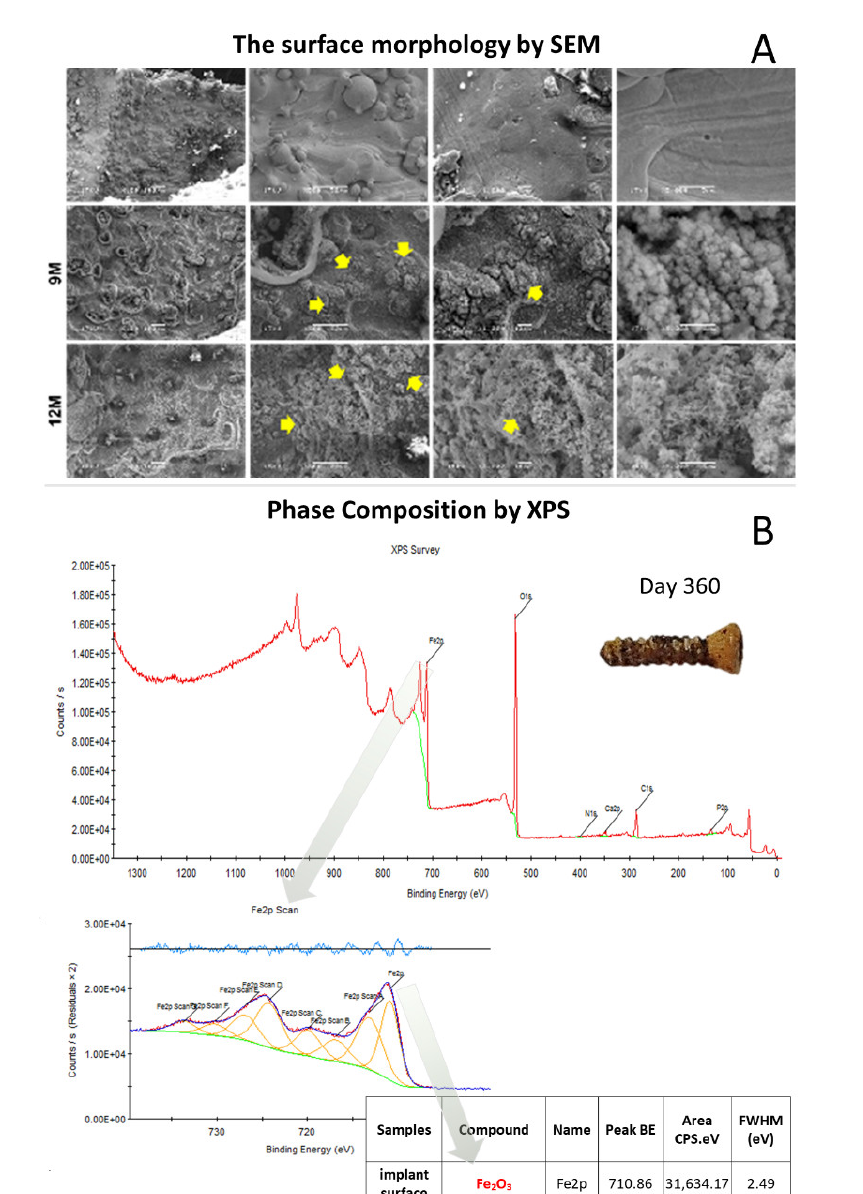
Figure 2. Surface morphology of Fe-based bioabsorbable interference screws retrieved on day 360 after in vitro immersion test observed using ( A ) scanning electron microscopy (SEM) and ( B ) phase composition X-ray photoelectron spectroscopy (XPS). The yellow arrows in ( A ) indicate surface- degraded iron oxides in the forms of needles and spheres. Fe 2 O 3 is the major compound identified using phase composition XPS in ( B